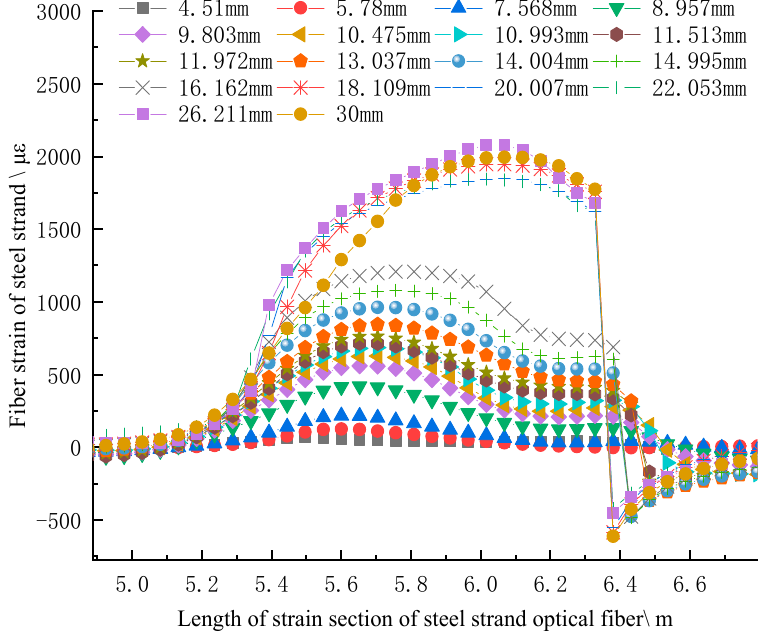
Figure 8. Strain curve of SS fiber under different length of anchor solid drawing deformation.